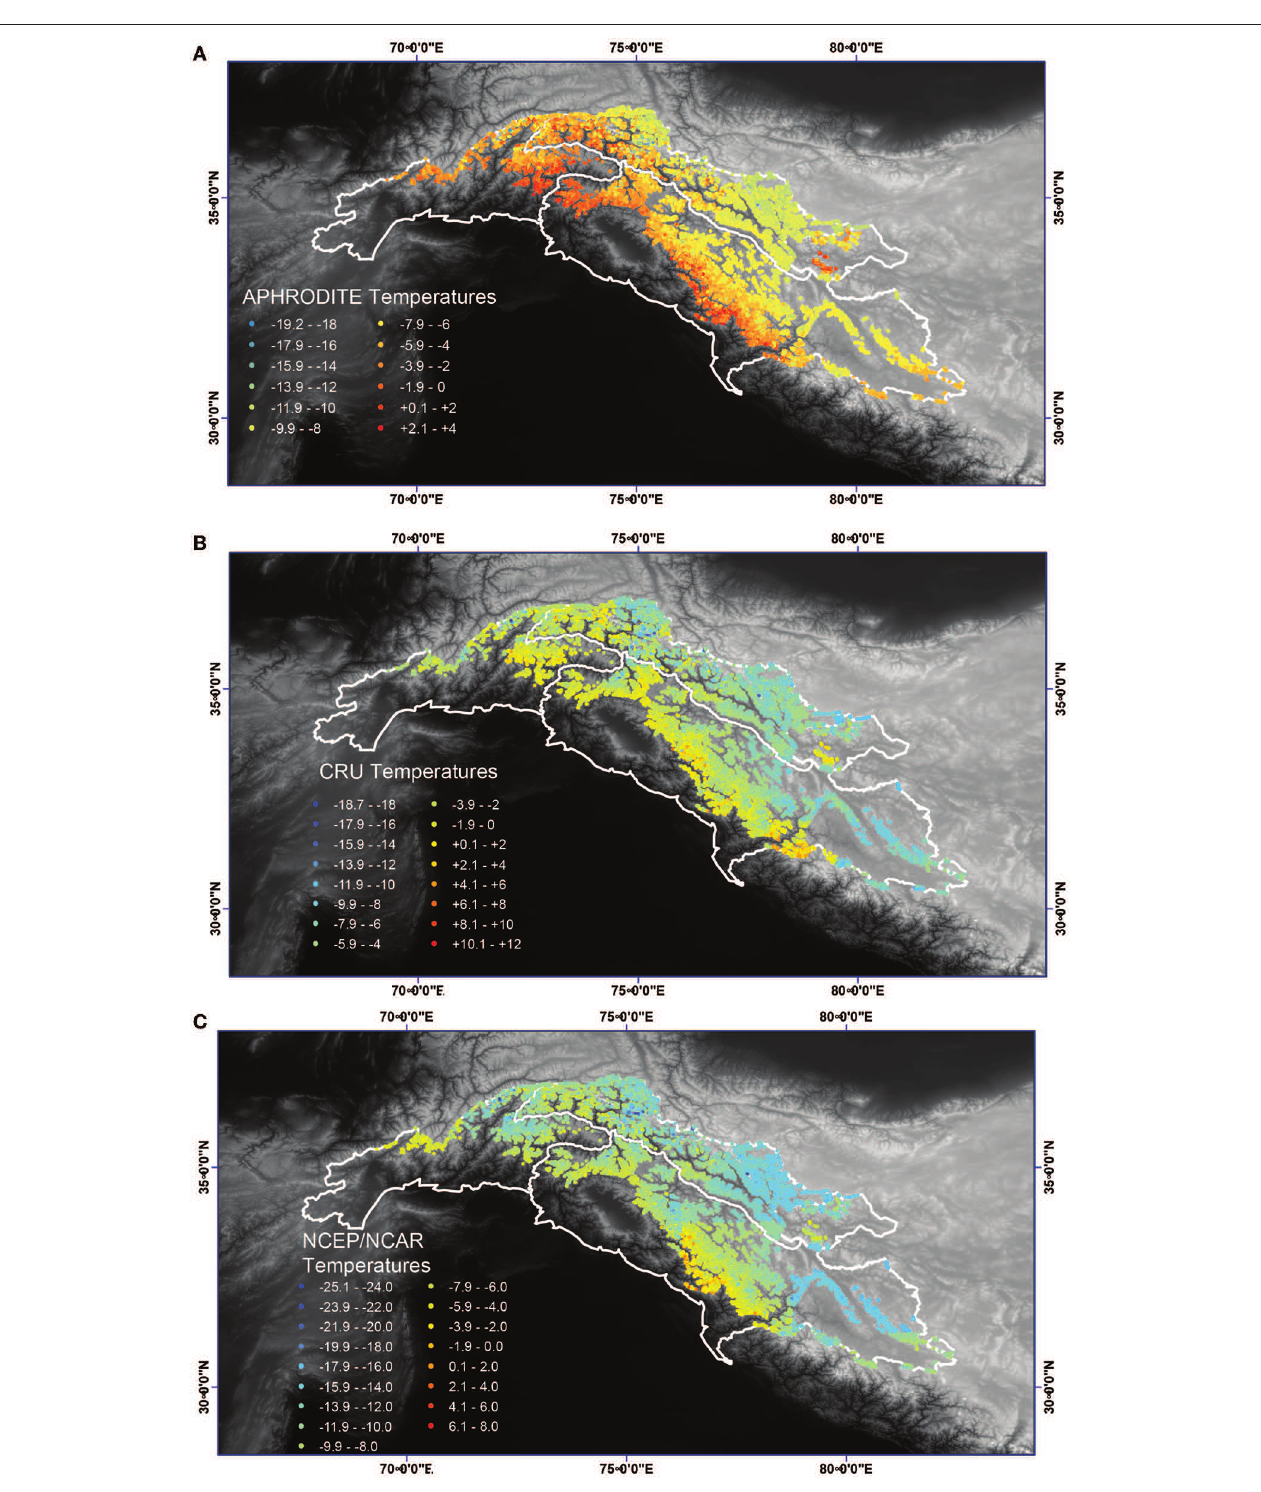
FIGURE 4 | Distribution of mean annual glacier 2m air temperatures (in ◦ C) at the mean glacier elevation across the Indus watershed. (A) using the APHRODITE, (B) CRU, and (C) NCEP temperature data. Note the temperature color scale varies for each dataset.